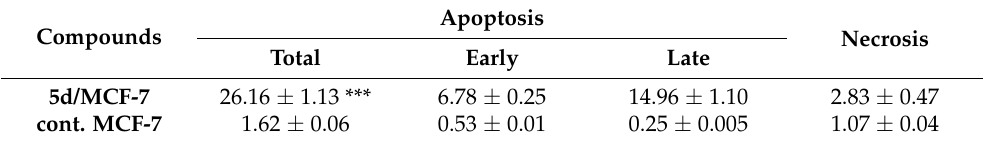
Table 4. Effect of compound 5d on apoptosis and necrosis in MCF-7 cells.